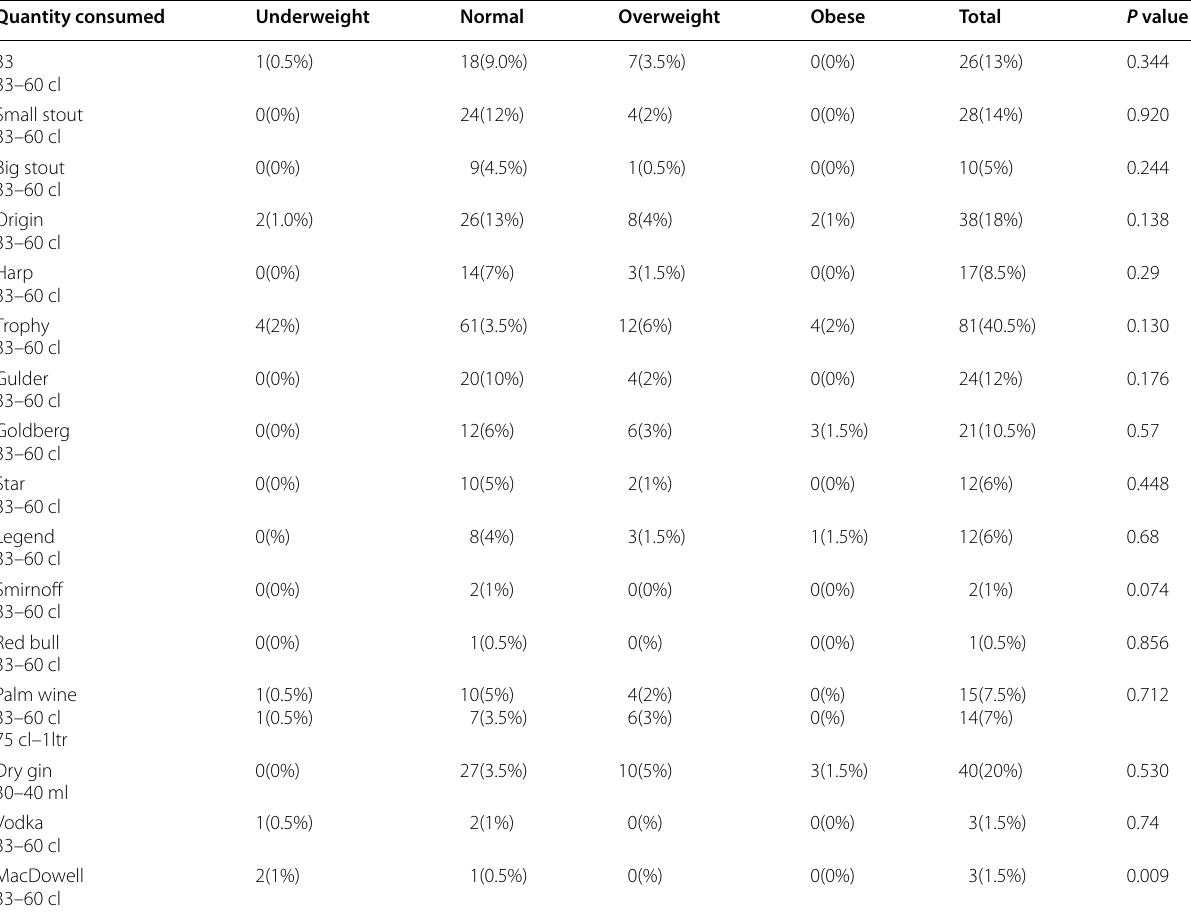
Table 7 Relationship between nutritional status and quantity of alcohol consumed by the respondents Quantity consumed